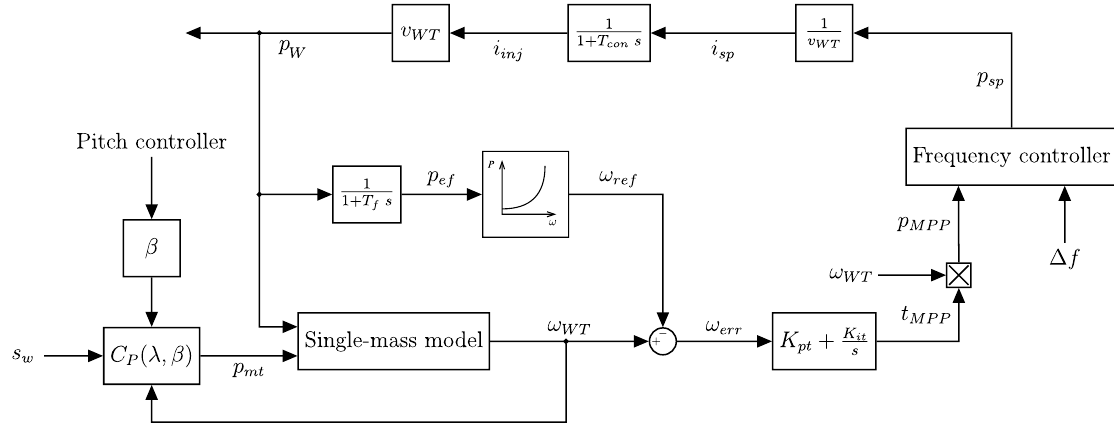
Figure 4. Block diagram of